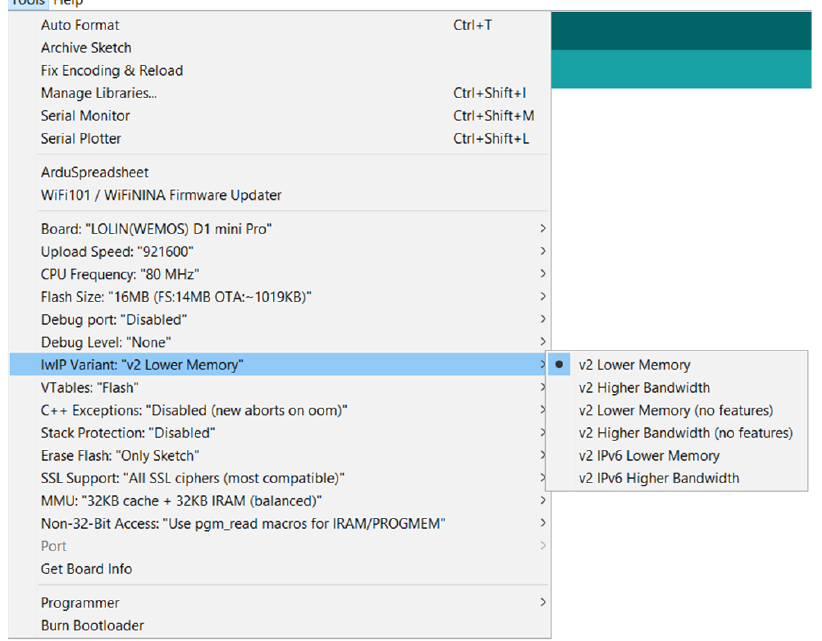
Figure 4. IwIP Variant configuration on Arduino IDE.